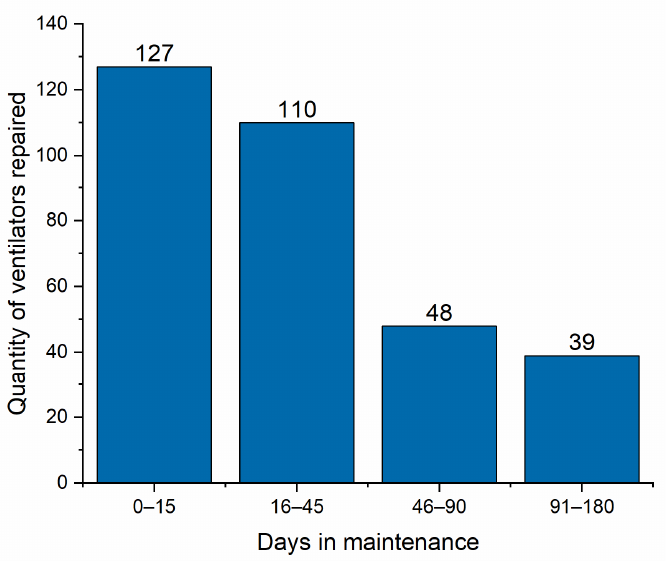
Figure 10. Number of ventilators repaired per time period at Reference Unit.